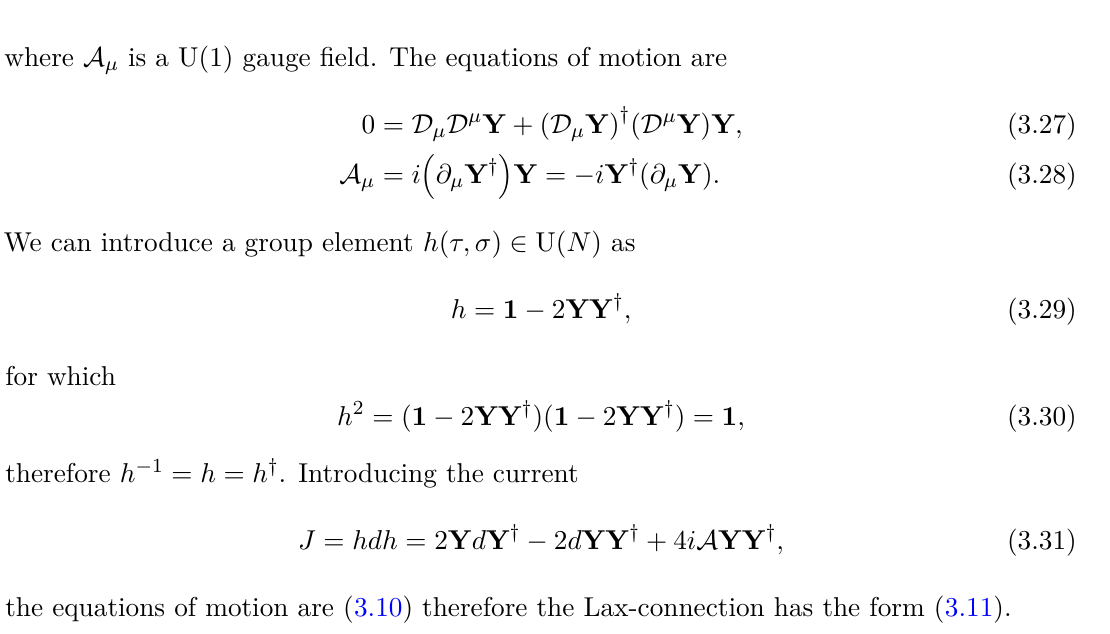
Figure 1 . Regions of the AdS N . The red lines are X − 1 = ± X N − 1 and they divide the AdS N to four regions. For example the region I is X . For the first Poincaré patch (3.22) X − 1 > | X N − 1 | − 1 > X N − 1 therefore it covers the regions I and II. For the second Poincaré patch (3.24) X − 1 > − X N − 1 therefore it covers the regions I and